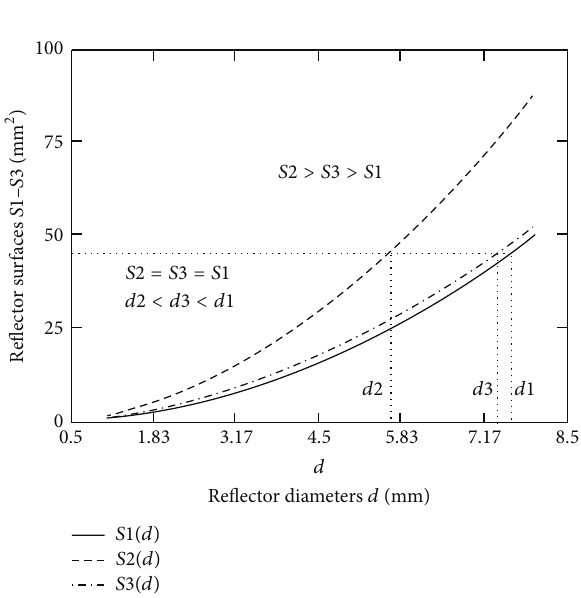
Figure 7: The dependence of reflector surfaces 𝑆1 – 𝑆3 on their reflector diameters 𝑑